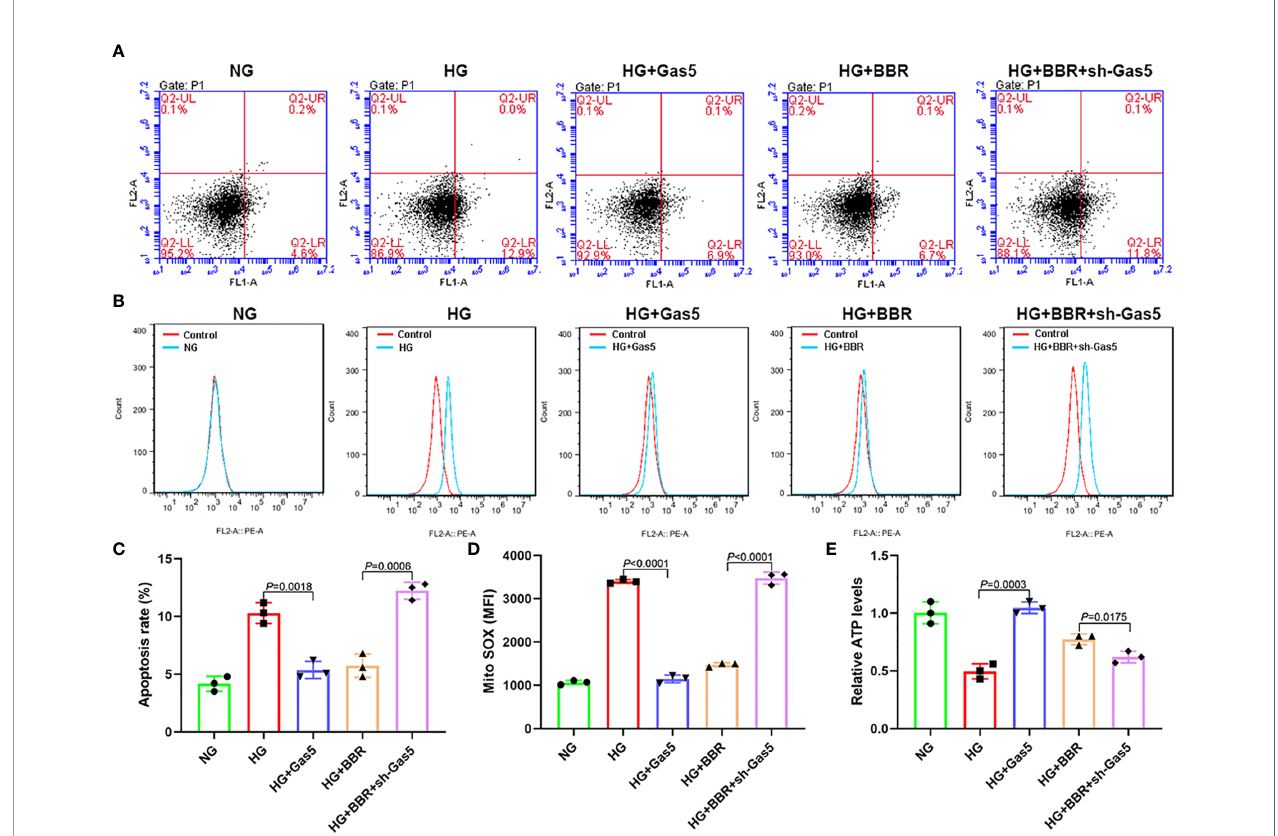
FIGURE 3 | BBR regulated mitochondrial ROS level of HK-2 cells in high glucose environment dependent on Gas5. (A, C) The proportion of apoptosis in different groups detected by fl ow cytometry. (B, D) Mitochondrial ROS in different groups detected by fl ow cytometry. (E) Relative ATP content in HK-2 cells of different